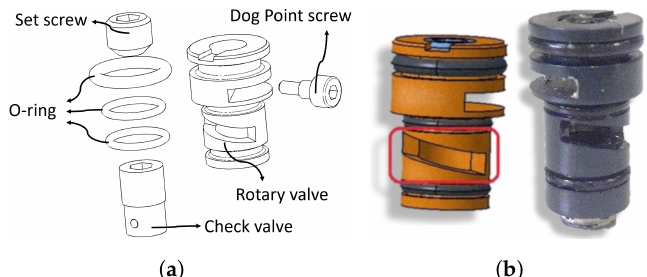
Figure 3. Exploded view ( a ) and final CAD and fabricated model ( b ) of the proposed rotary flow control valve embedded in the H2AP hydraulic damper.